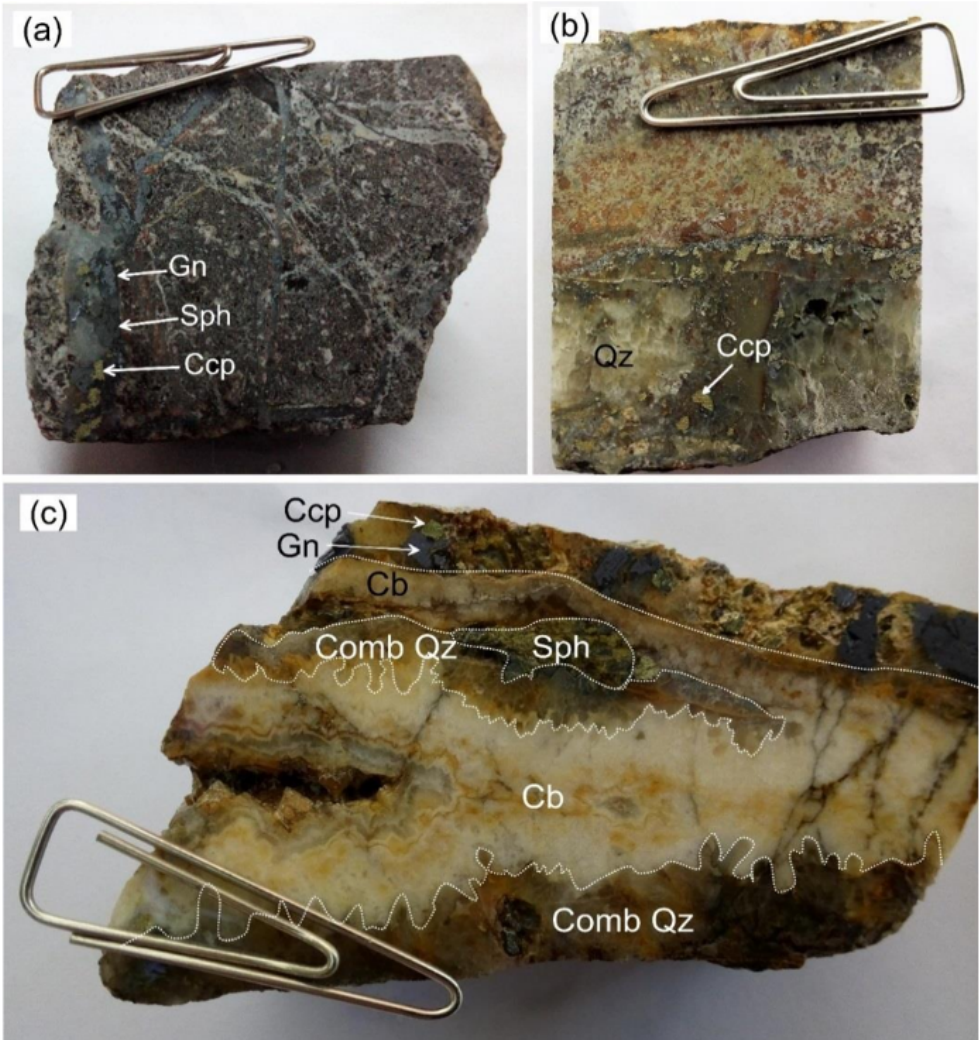
Figure 9. Photographs of hand samples showing: ( a , b ) Silica-sulfide vein-veinlets including galena (Gn), sphalerite (Sph), and chalcopyrite (Ccp); ( c ) Silica-carbonate-sulfide vein containing typical crustiform banding and comb